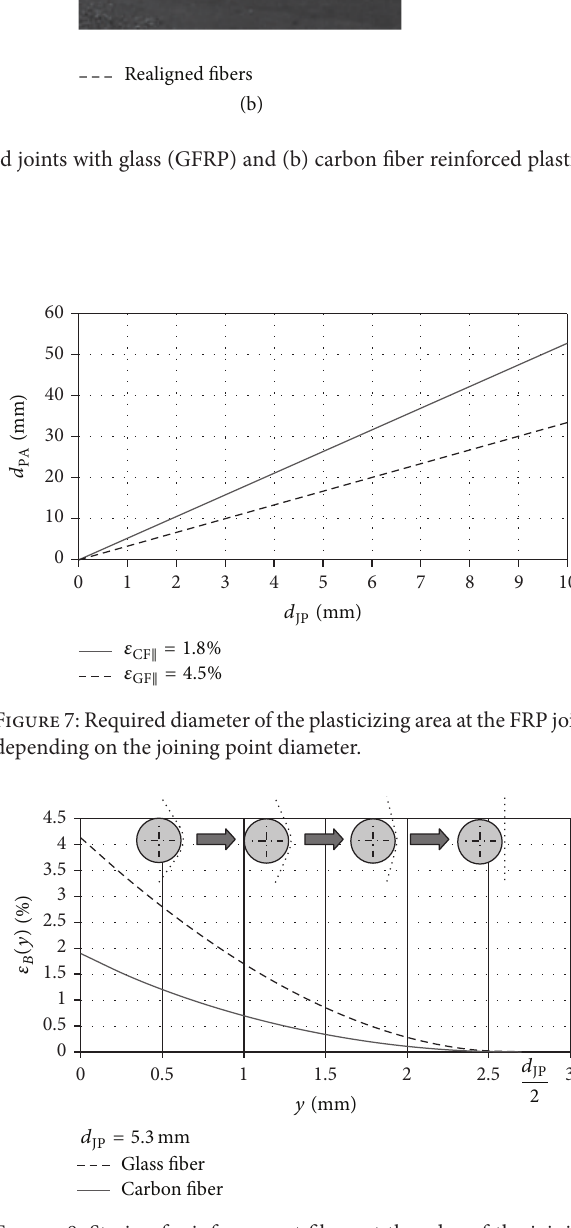
Figure 8: Strain of reinforcement fibers at the edge of the joining point in the plasticized joining